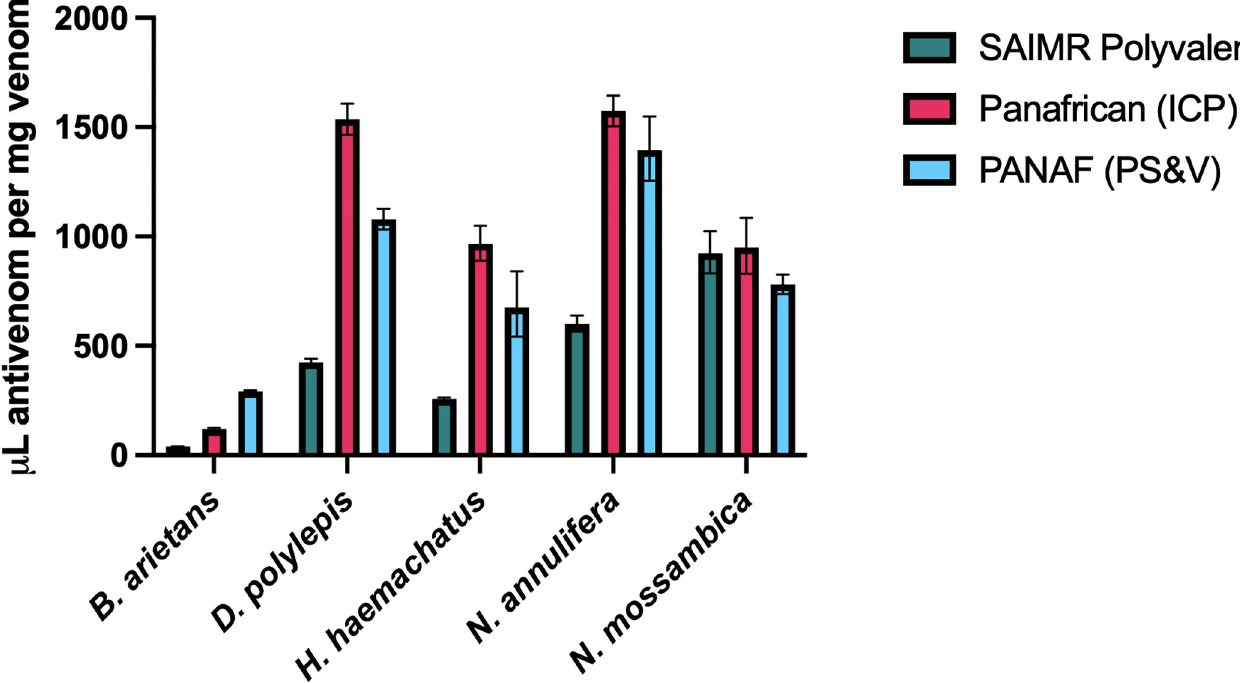
Fig 1. ED 50 of the three antivenoms against each of the five Eswatini venoms, expressed as μ L per mg of venom. SAIMR Polyvalent (SAVP) shown in teal, Panafrican (ICP) shown in magenta, PANAF Premium (PS&V) shown in blue. ED 50 was determined using Probit analysis, data represents the calculated ED 50 and error bars represent 95% confidence intervals. The units used ( μ L per mg of venom) attempts to normalise reporting to the amount of venom used to compensate for differences in number of venom LD 50 s used, however for clarity, a 3 x LD 50 venom dose was used for the following groups; H . haemachatus with PANAF (PS&V) antivenom, N . annulifera with Panafrican (ICP) antivenom, and N . annulifera with PANAF (PS&V) antivenom. All other experiments used 5 x LD 50 venom dose.